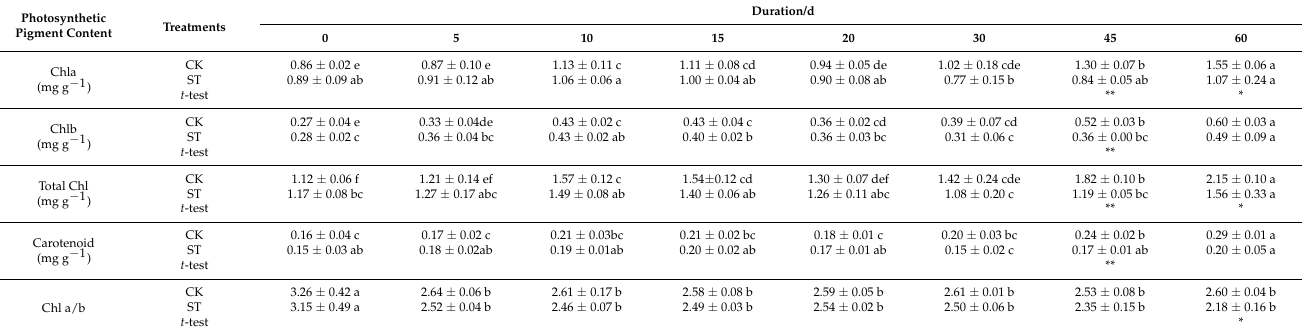
leaves was weakened after a longer duration of salt stress.